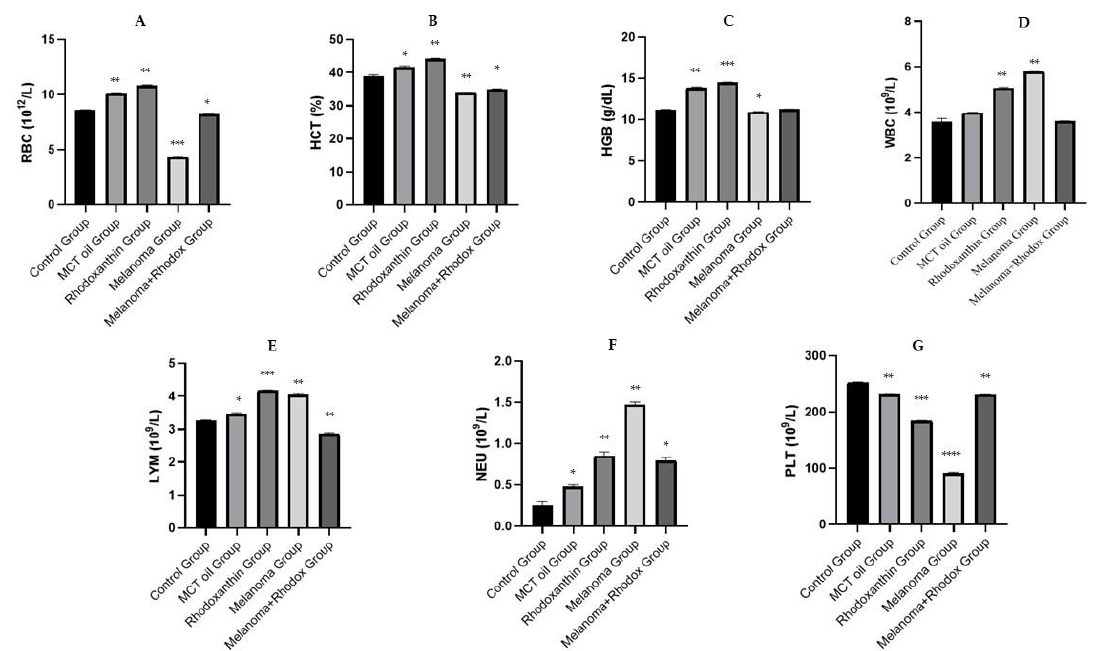
Figure 4. Hematological profile data. ( A ) Red blood cell count. ( B ) Hematocrit. ( C ) Hemoglobin. ( D ) White blood cell count. ( E ) Total lymphocyte count. ( F ) Total neutrophils count. ( G ) Platelet count. Values are expressed as mean ± standard deviation SD from three independent experiments. Statis-